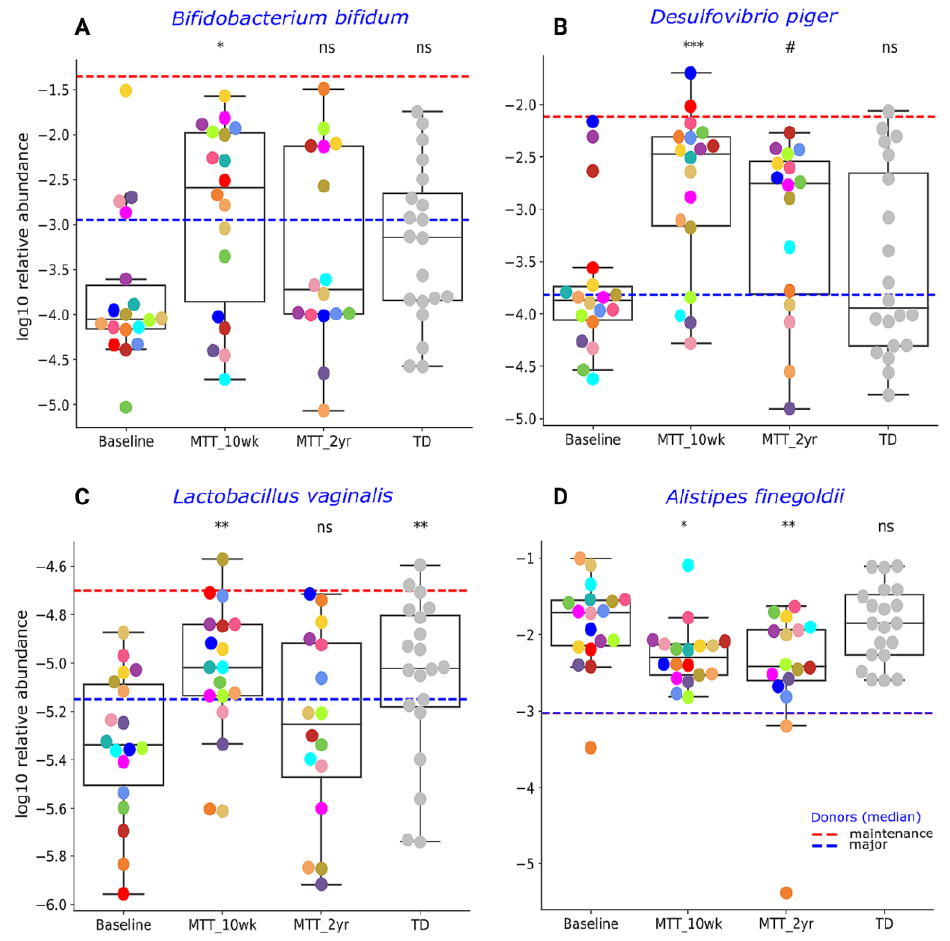
Figure 4. Univariate comparison of the relative abundance (after log 10 transformation) of different bacterial species: ( A ) Bifiodobacterium bifidum, ( B ) Desulfovibrio piger, ( C ) Lactobacillus vaginalis and ( D ) Alistipes finegoldii for ASD Baseline vs. all other groups. Red-dashed lines represent the mean of maintenance donors ( n = 2) and blue represents the median of major donors ( n = 5); for A. finegoldii , the red and blue lines overlap. Each colored dot represents one ASD individual and grey-colored dots represent TD. Asterisks represent significant differences between ASD Baseline and the other groups (* single asterisk indicates p < 0.05; ** double asterisks indicate p < 0.01; triple *** asterisks indicate p < 0.001; #: statistically significant only after log 10 transformation; ns: not significant; all p -values are FDR-corrected). ASD: autism spectrum disorder; TD: typically developing.